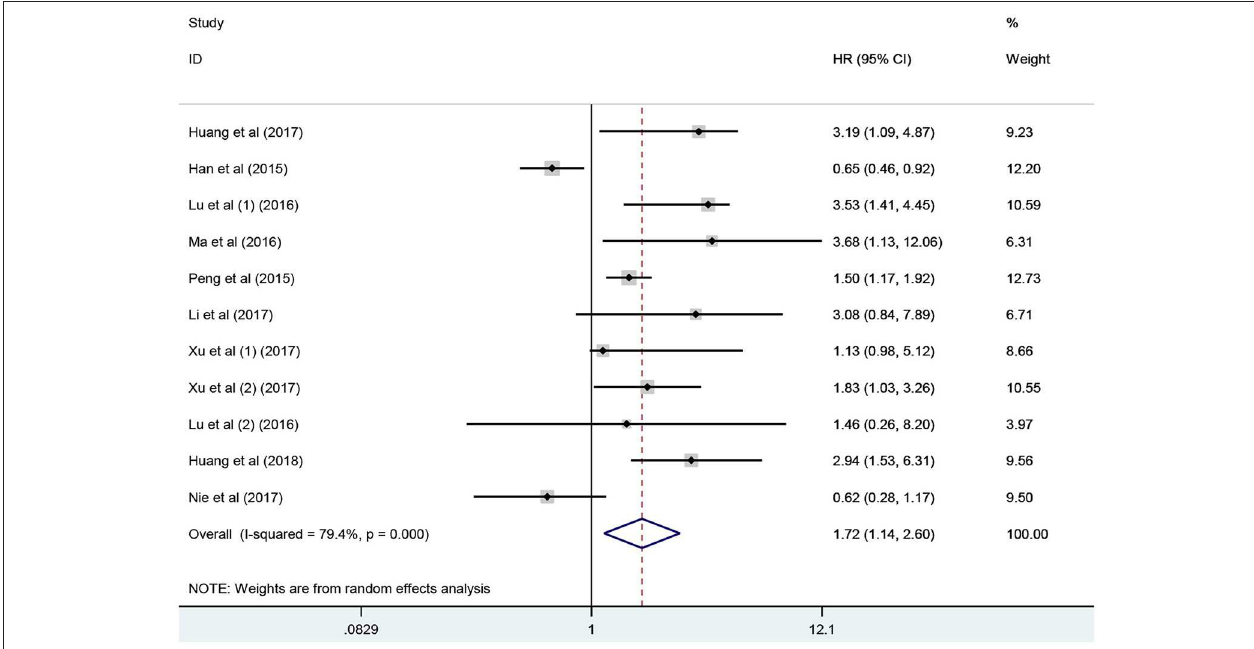
FIGURE 2 | Meta-analysis of the pooled HR of OS for malignancy